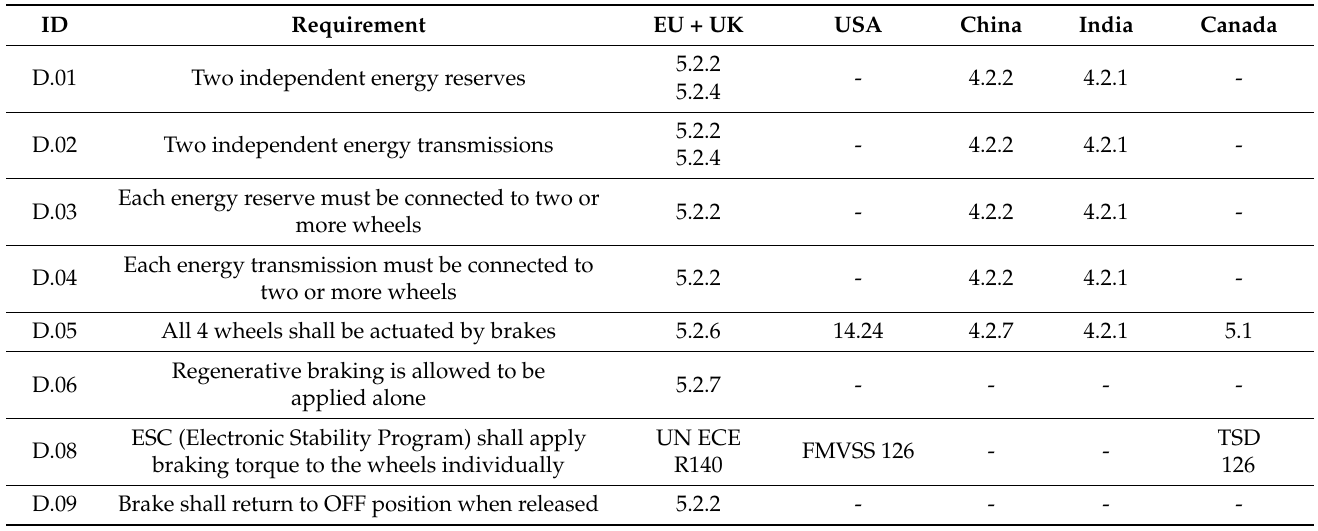
Table 1. Sections of the standard documents related to the design requirements for intact EMB service braking systems.